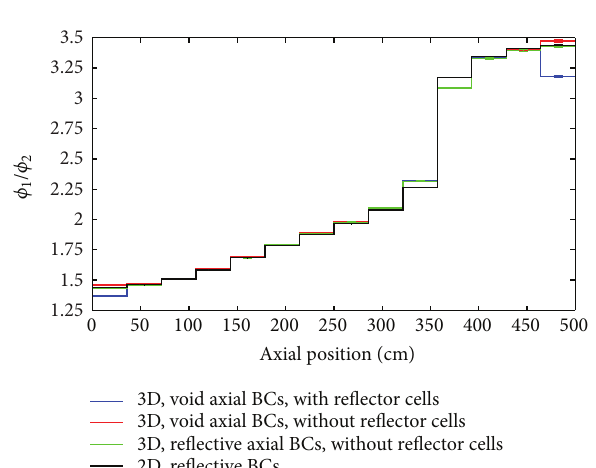
Figure 11: Relative differences between absorption cross sections for the fast group.